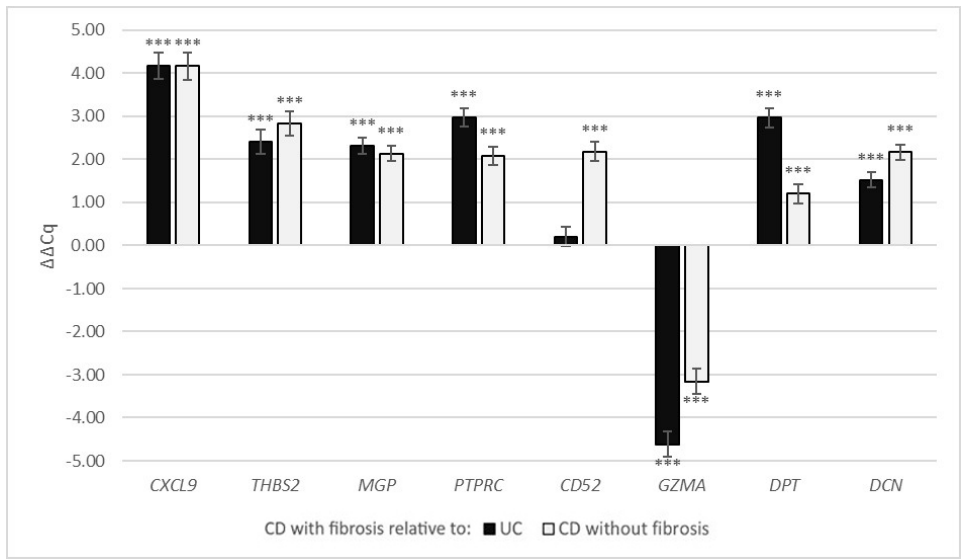
Figure 4. Gene expression of CXCL9 , THBS2 , MGP , PTPRC , CD52 , GZMA , DPT and DCN in colonic CD with fibrosis as ΔΔ Cq relative to colonic CD without fibrosis and UC. Legend: *** p ≤ 0.001; CD, Crohn’s disease; UC, ulcerative colitis.